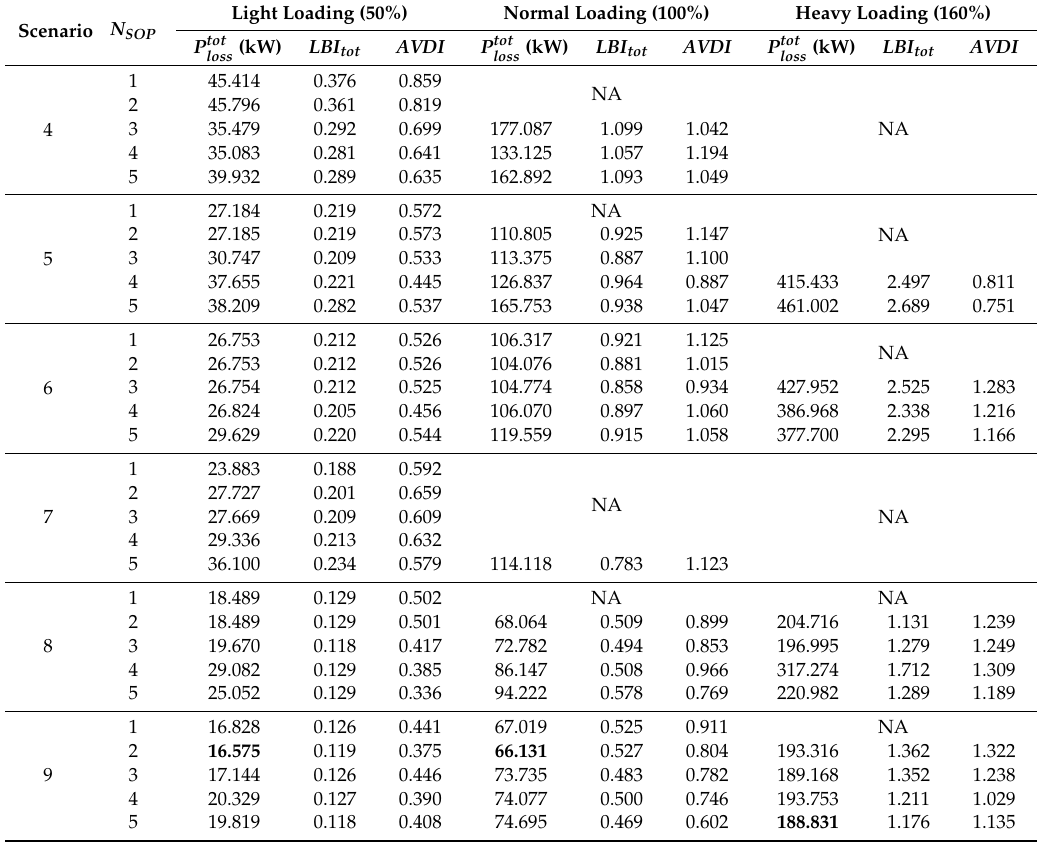
Table 4. Total Power Losses and PQ Indices for Scenarios 4 to 9 with SOP Losses Considered: IEEE 33-node system.